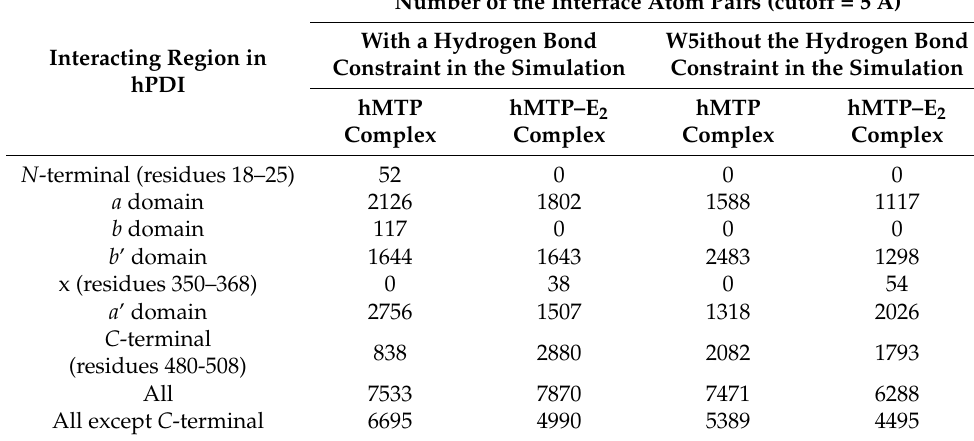
Table 1. Number of the interface atom pairs between hPDI and hMTP α subunit in the four confor- mations of hMTP and hMTP–E 2 complexes after MD simulations.